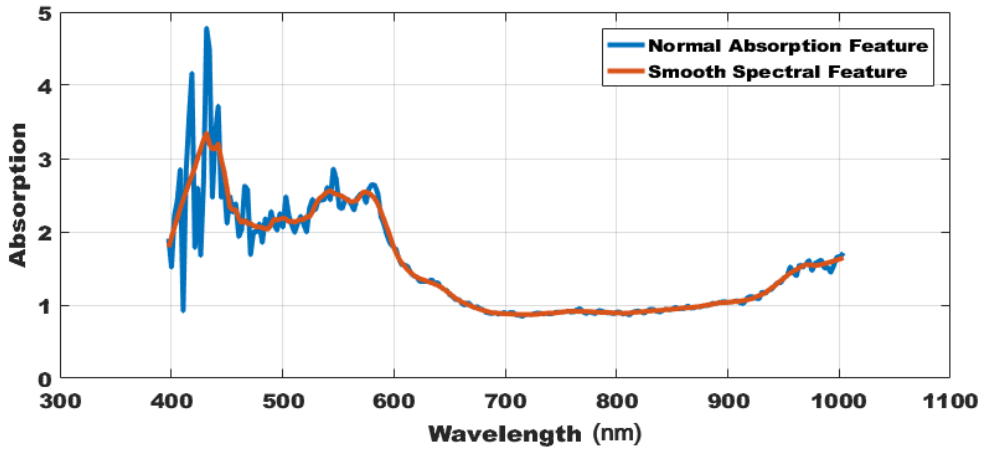
Figure 3. Comparison between pre-processed spectrum (Smoothing spectrum) and computed spectrum (normal spectrum) of Bovine minced